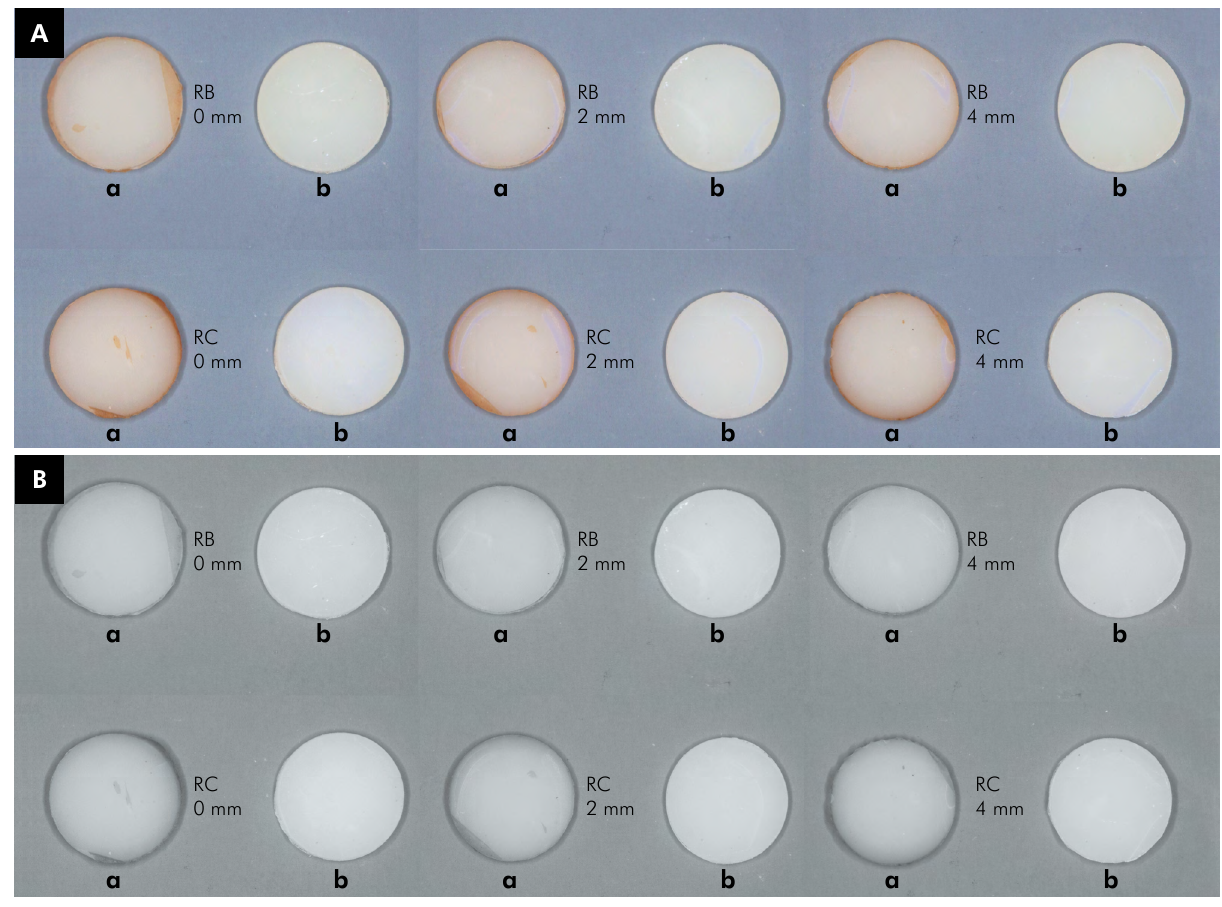
Figure. Specimens before and after coffee staining at all curing distances (A - color; B - black and white; RB = resin composite bulk-fill; RC = resin composite conventional; b = before coffee staining; a = after coffee